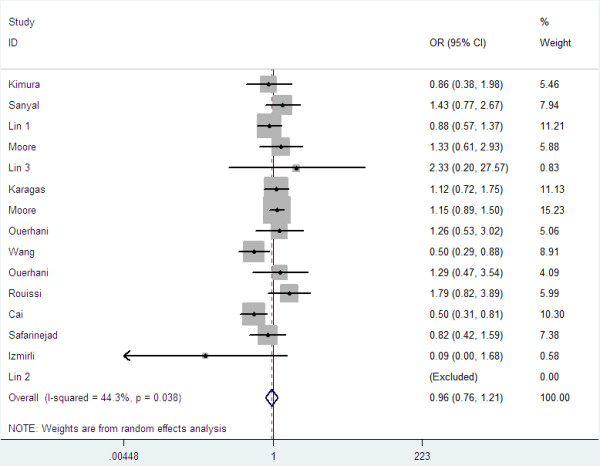
Forest plots for MTHFR Ala222Val polymorphism and risk of bladder cancer in overall populations (Ala/Ala versus Val/Val).